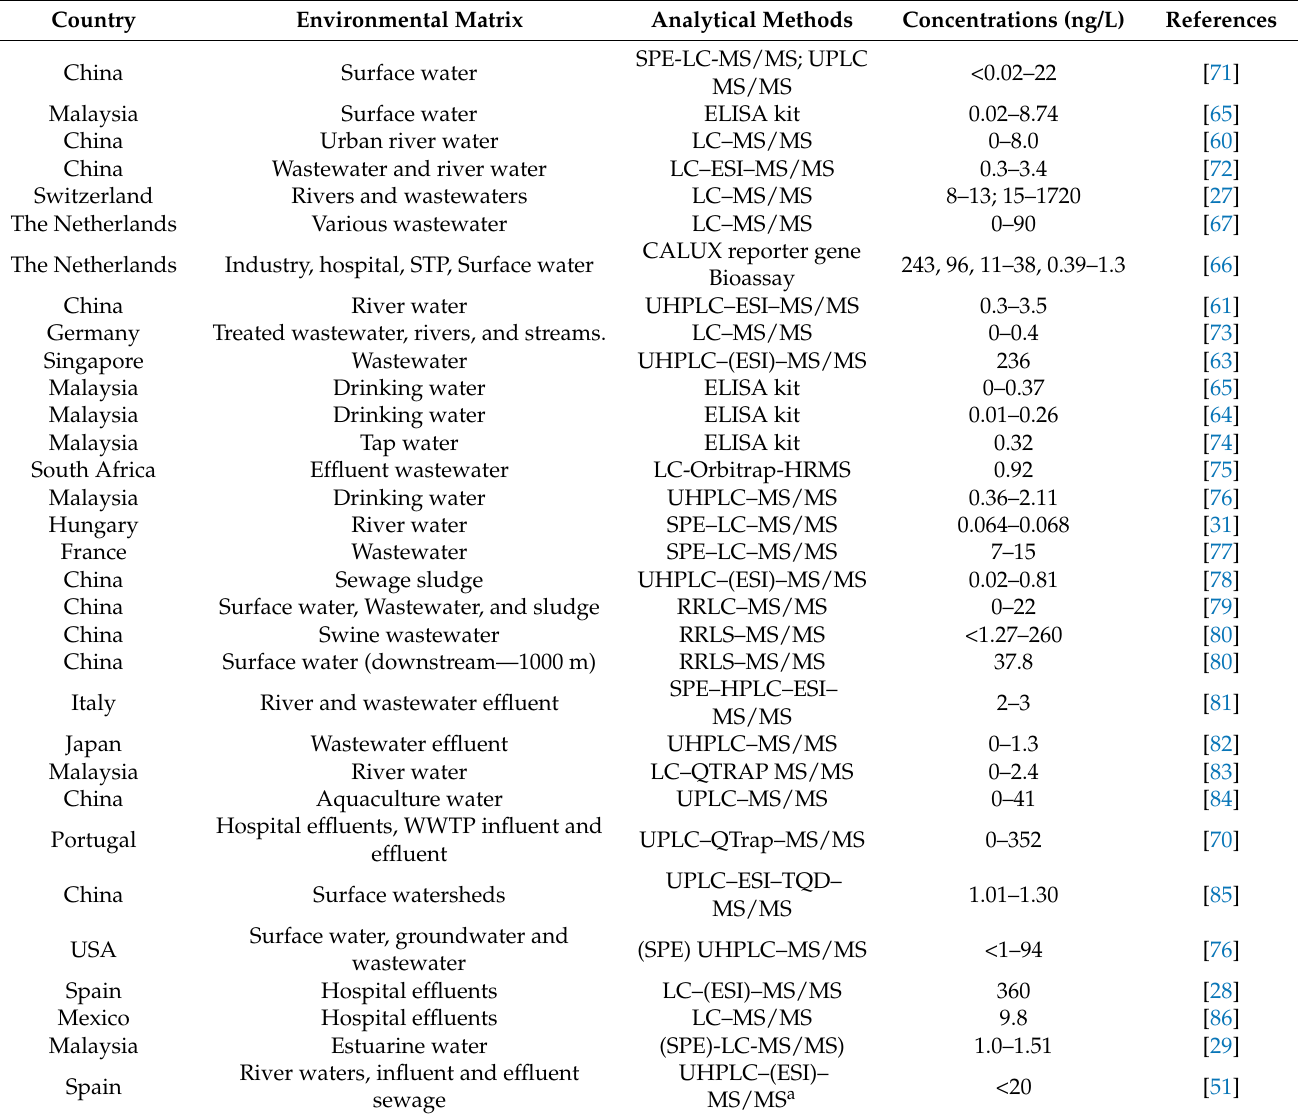
Table 2. Global concentrations of dexamethasone in environmental